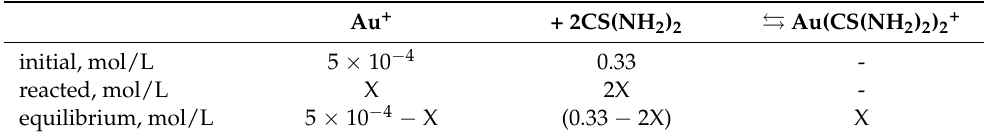
Table 1. Equilibrium concentration calculated.